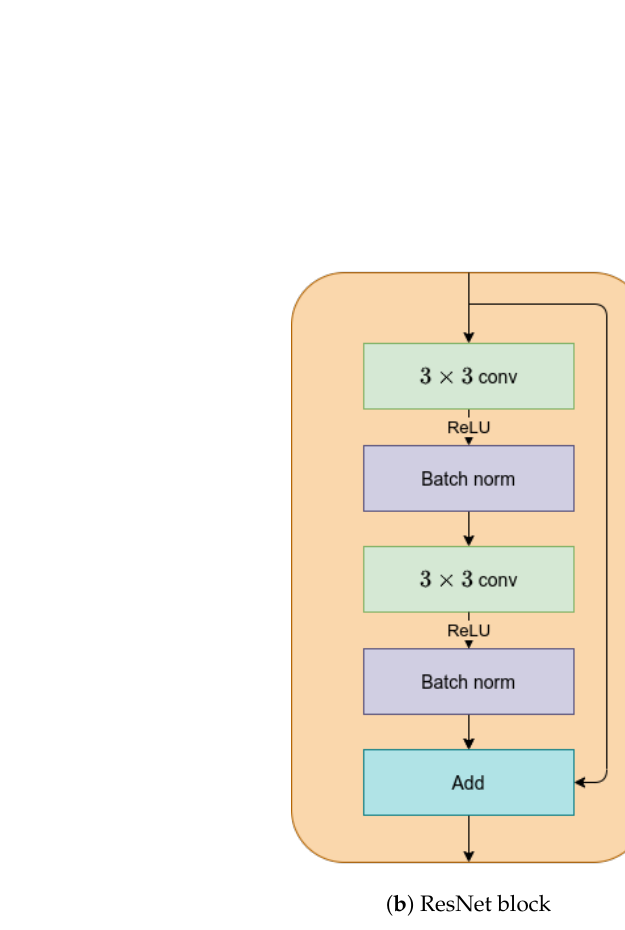
Figure 2. ( a ) The scheme of the res8 neural network used in our experiments. The shape of the resulting tensor is specified after each block in square brackets. FC stands for the fully-connected layer. conv stands for the convolutional layer. T is the number of frames in a sample. B is the number of channels in the audio features. M is the number of feature maps (45 for res8 ). C is the number of classes to discriminate. Note that the first average pooling layer operates in the time and frequency dimensions, making them smaller, and the second such layer reduces them to one, essentially removing these dimensions. ( b ) shows the detailed schema of each residual